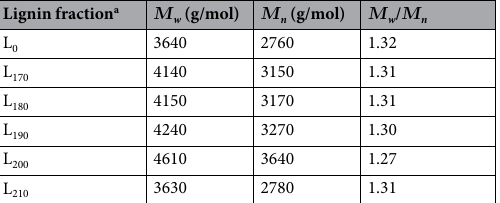
Table 2. Weight-average ( Μ w ) and number-average ( Μ n ) molecular weights and polydispersity indices ( Μ w / Μ n ) of the lignin fractions obtained from Eucalyptus . a Corresponding to the lignin fractions in Table